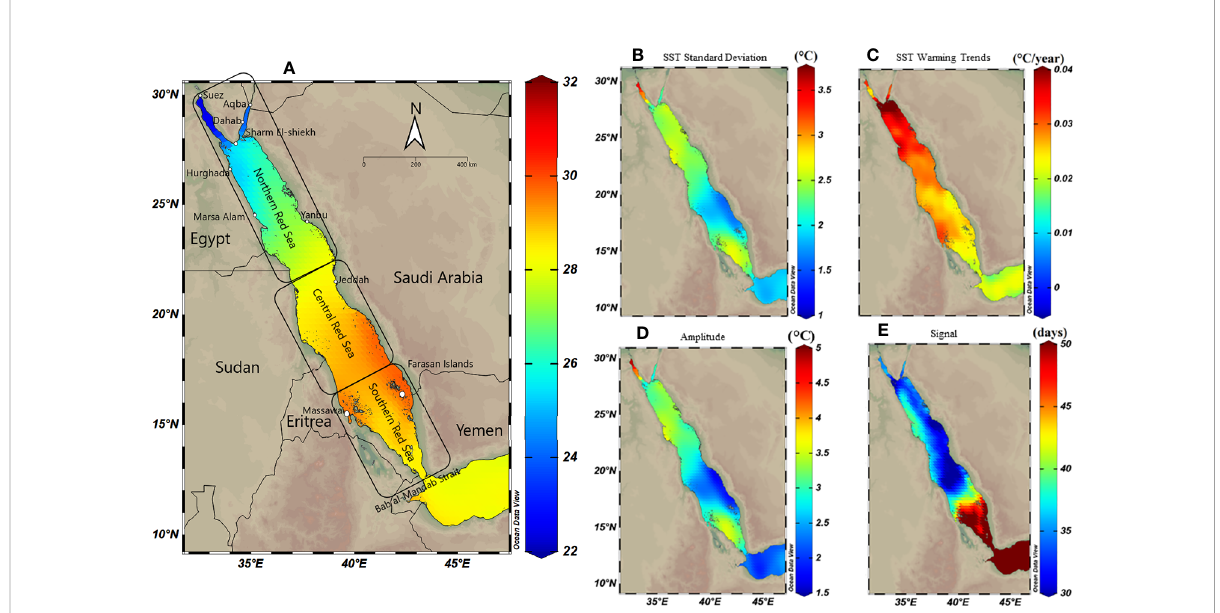
FIGURE 1 Spatial distribution maps of sea surface temperature (SST) variability along the Red Sea using Optimum Interpolation Sea Surface Temperature (OISST V.2) remote sensing data from 1982 to 2020. The Red Sea was divided into three regions; the northern, central and southern Red Sea. (A) Annual mean SST exhibiting a gradual decline toward the north. (B) SST standard deviation exhibiting declines to the south (except for the most southern region), suggesting higher SST variability in the north (particularly the Gulf of Suez) compared to the central and southern Red Sea. (C) Warming trend, using Theil – Sen estimator method (TSE), over 39 years along the Red Sea exhibiting a high trend in the northern compared to the southern region (warming trends using TSE represent slightly lower trends compared to the ordinary least square in the northern Red Sea – see Figure S3). (D) Spatial distribution of seasonal variations (i.e., the amplitude) exhibiting higher variability in the north compared to the south; and (E) Spatial shift in the seasonal cycle (i.e., phase lag), and the number of days highlighting ca. 30-50 days shift between seasons starts between north and